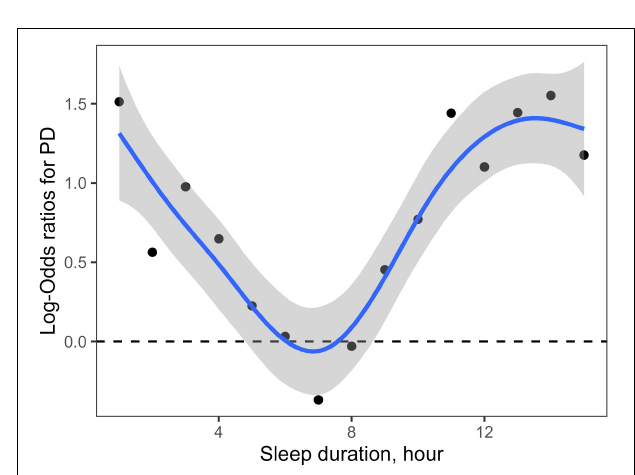
FIGURE 2 | Non-linear association of sleep duration with risk of PD. Each node represents the logarithm of OR value of the corresponding sleep duration increasing the risk of PD. The shaded area represents the 95% confidence interval of the logarithm of OR value. This figure shows a curvilinear U-shaped correlation of sleep duration with the risk of PD.